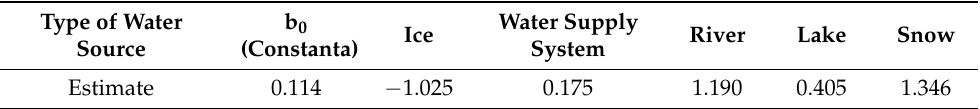
Estimated parameters of the impact of the type of water sources on the risk of arterial